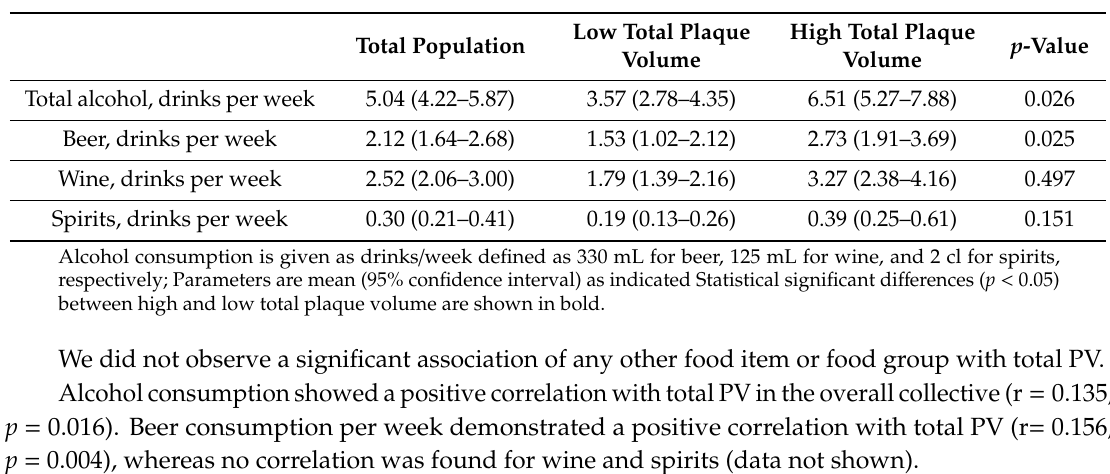
Table 3. Association of total plaque volume depending on alcohol